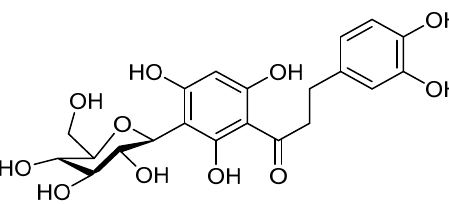
Figure 1. Chemical structure of aspalathin.